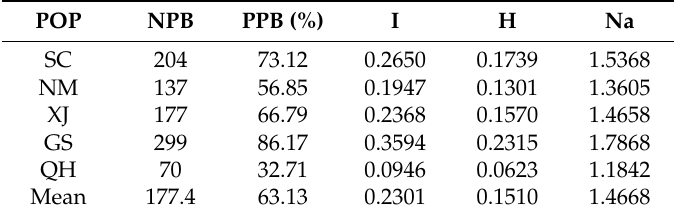
Table 3. Genetic variability within five geographic regions of E. sibiricus .